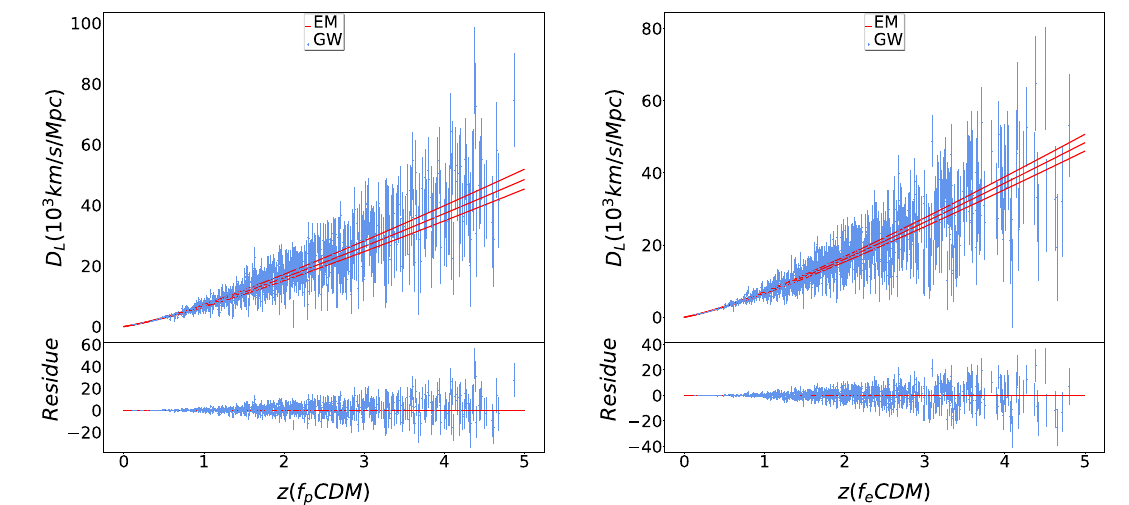
Fig. 1 The data with error-bar are the simulated GW data. The red lines are the best fitted values and the 1 σ errors from the EM fitting results. Specifically, the left panel is for the f p CDM model, while the right panel is for the f e CDM